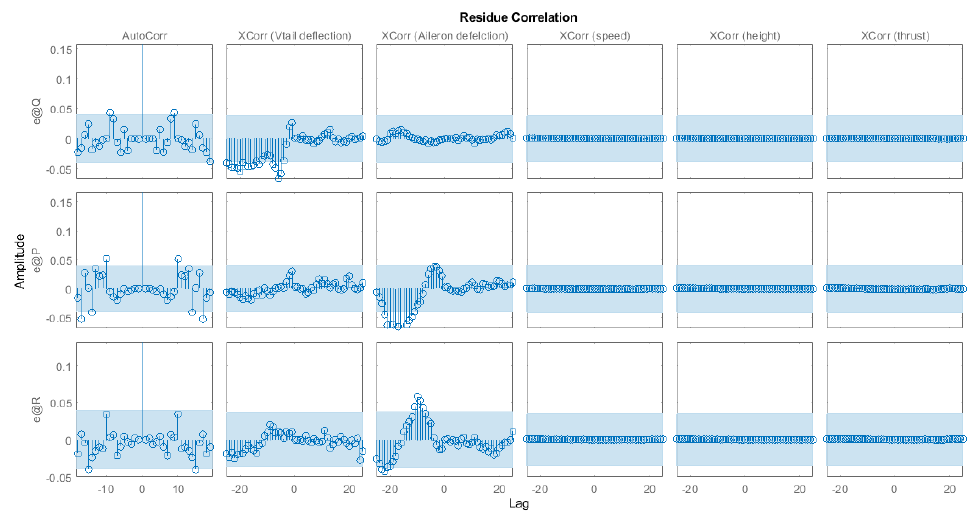
Figure 13. ARMAX Model Residue Correlation.